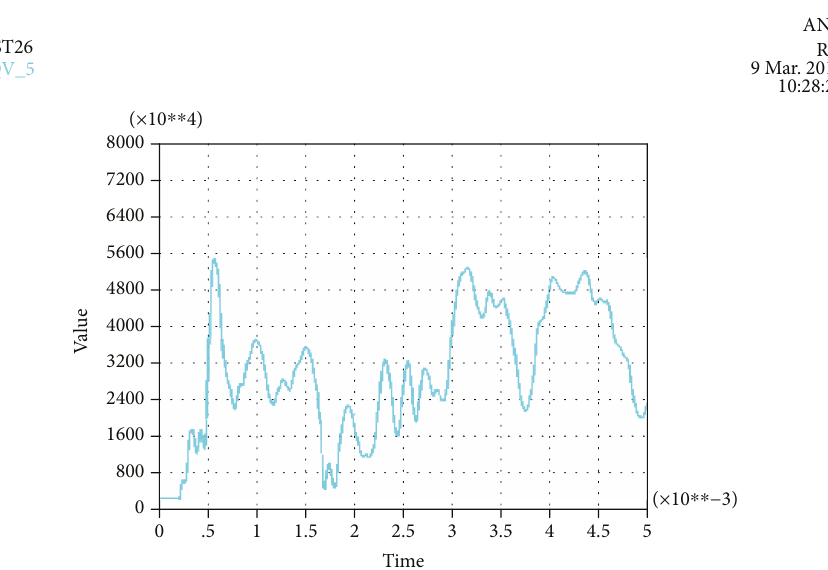
Figure 18: Mises stress response of the No. 1439